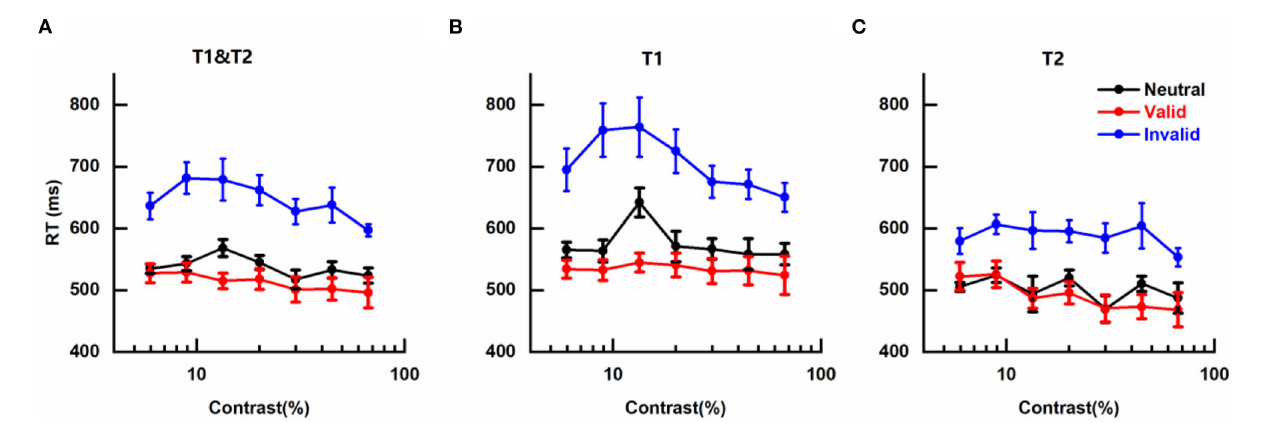
FIGURE4 Effects of cue-induced temporal attention on reaction time (A) mean reaction times (RTs) across targets, plotted for different pre-cues as a function of contrast intensity. Error bars on data points denote within-subject standard errors of the mean, after the removal of the between-subject variability (Cousineau, 2005; Morey, 2008; Franz and Loftus, 2012; Baguley, 2013). (B) same as (A) but only for trials in which the reported target was T1. (C) same as (A) but only for trials in which T2 was the reported target.